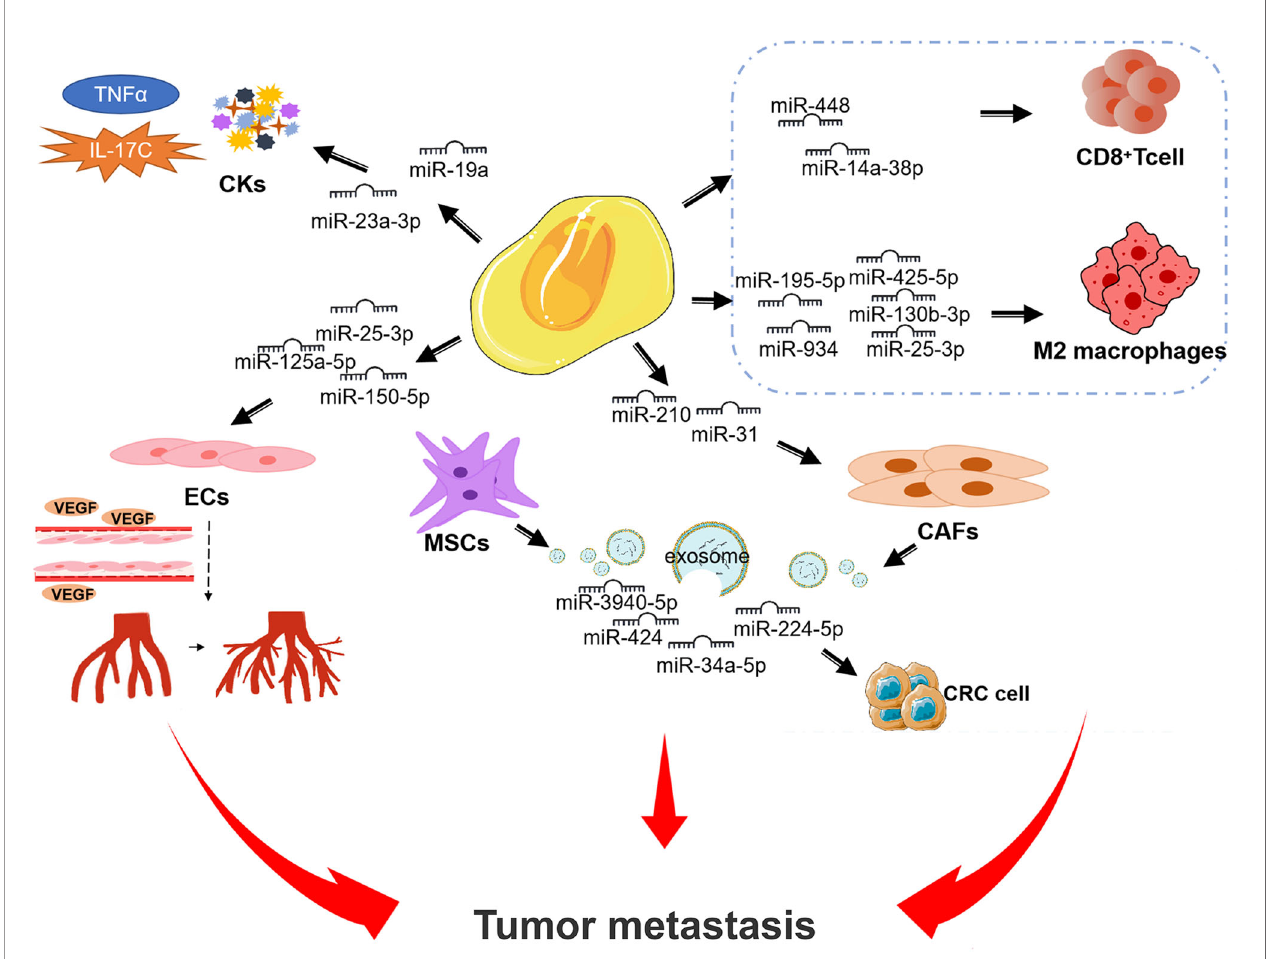
FIGURE 2 | miRNAs affect the progression of CRC mediated by different components in